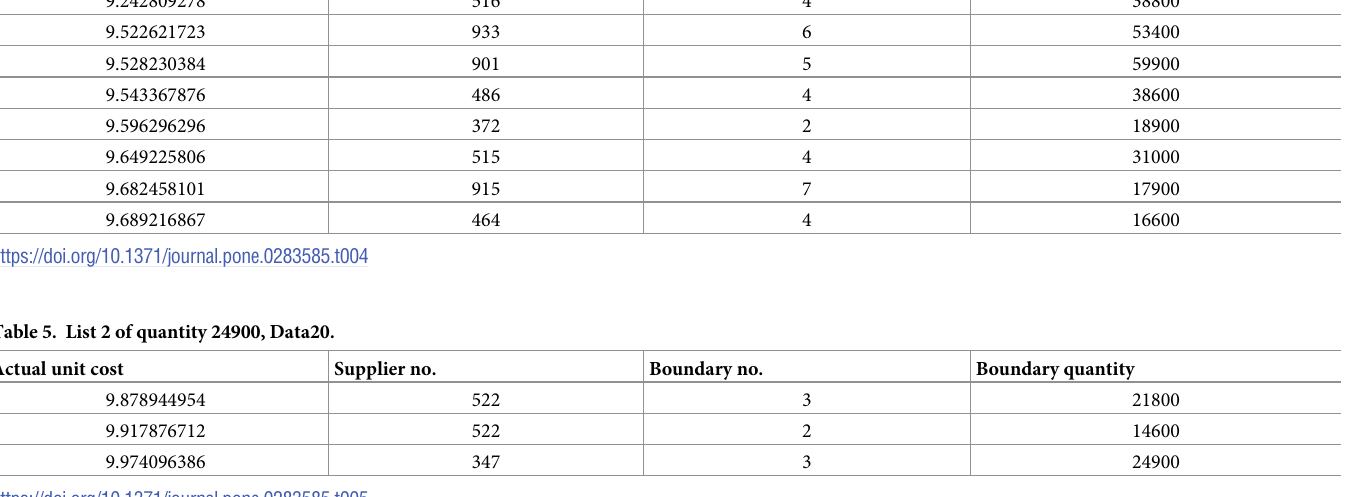
Table 4. List 1 for Q = 300000, Data20, no repetitive supplier no. allowed. Actual unit cost